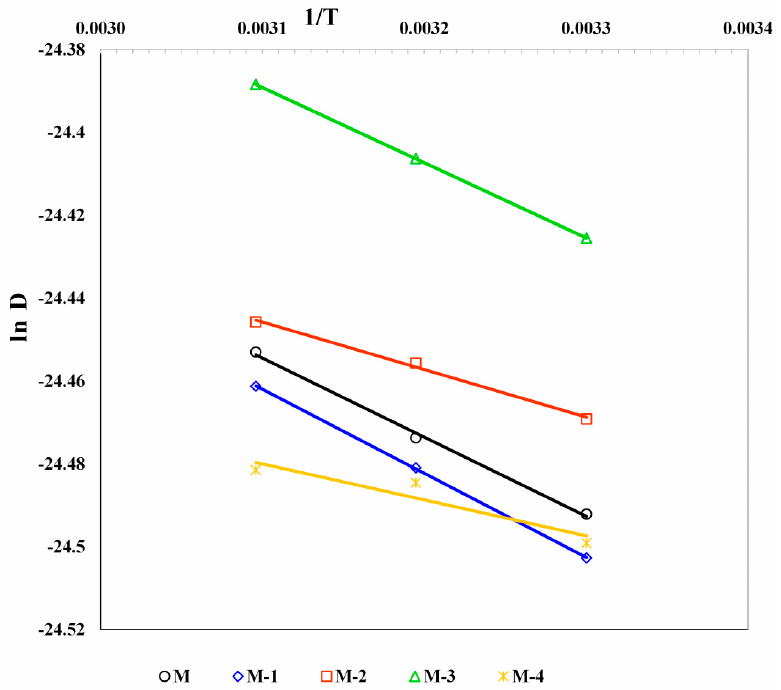
Figure 8. Effect of Ge content in NaCMC membranes on diffusivity with temperature.